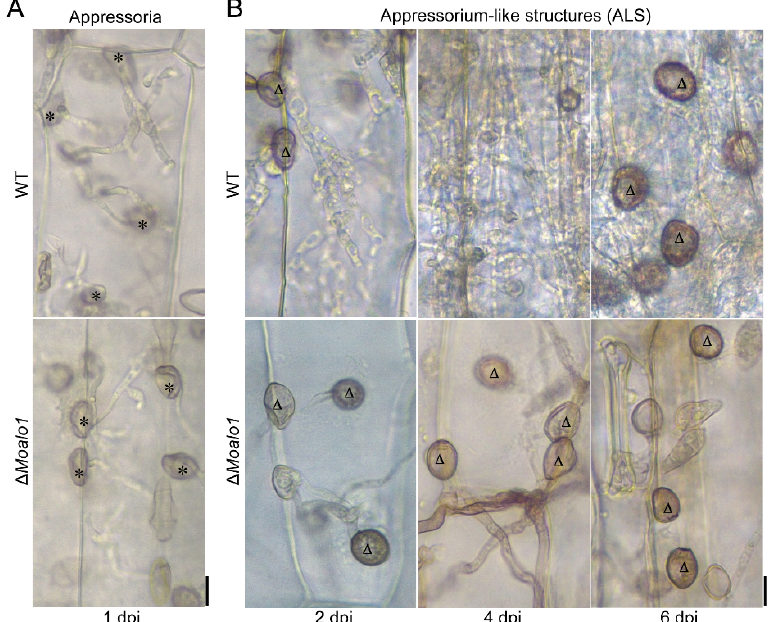
Figure 5. The penetration test of Δ Moalo1 in barley. ( A ) The penetration test of the appressoria developed by conidia. Photographed after inoculation on cut barley leaves for 1 day. Asterisks indicate appressoria ( B ) The penetration test of the appressorium-like structures (ALS). Photographed at 2, 4, and 6 dpi on barley leaves. Triangles indicate ALS. Bar = 10 μ m.